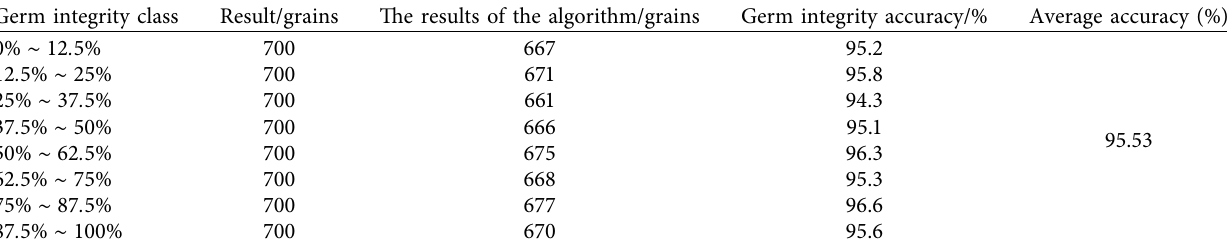
Table 6: Test results.